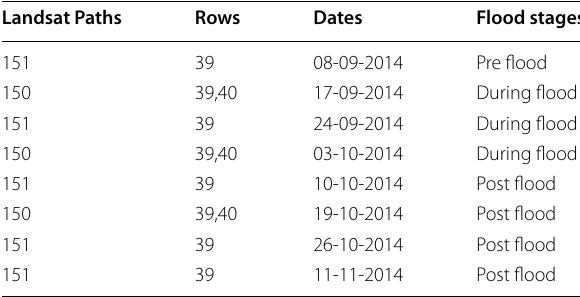
Table 1 Characteristics of Landsat 8 (OLI) images used in the present